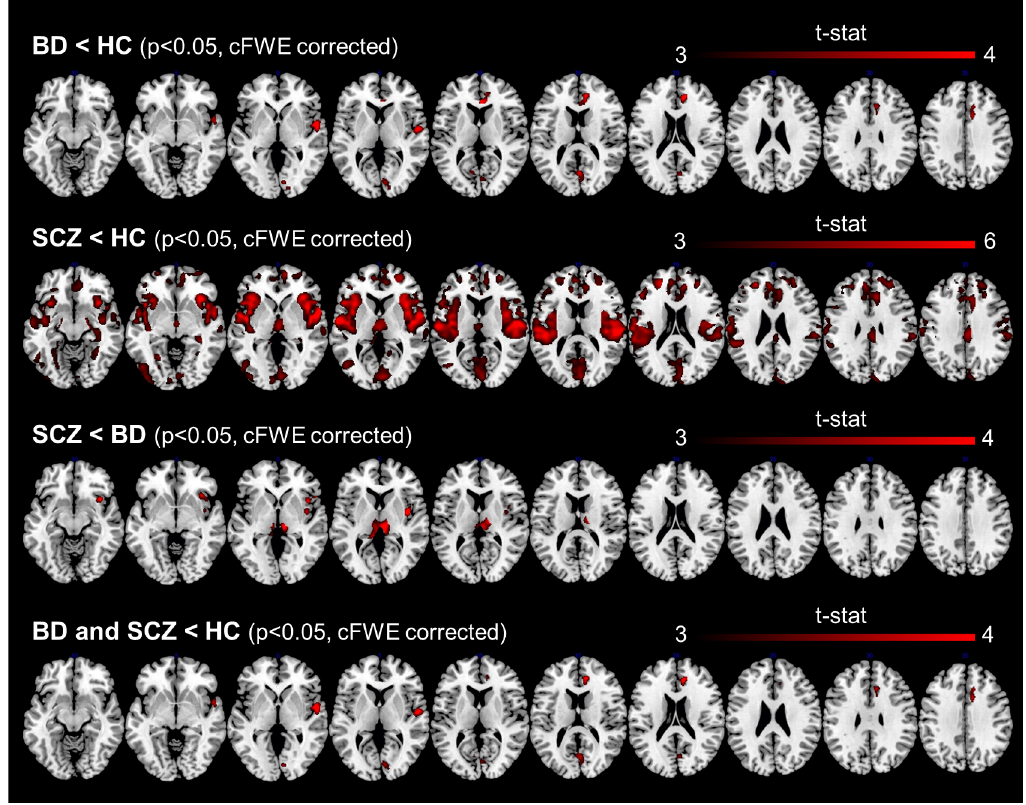
Fig 1. Results of the VBM analysis of Dataset1: regions with significant GMV difference between SCZ, BD and HC (p < 0.05, cFWE corrected). VBM: voxel based morphometry. GMV: gray matter volume. SCZ: schizophrenia. BD: bipolar disorder. HC: healthycontrols. cFWE: cluster family wise